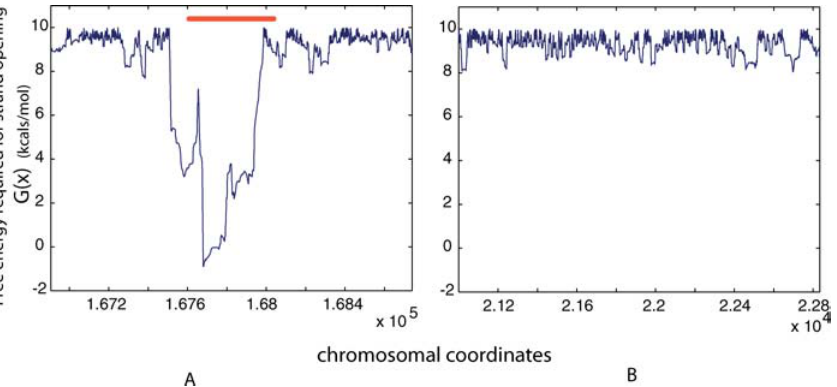
Figure 3. ARS Elements Are More Destabilized Than Other Parts of the Genome (A) The SIDD profile of a region (bp 166936–168740) of Chromosome 6, containing ARS606 (position marked in red). (B) For contrast, the SIDD profile of a randomly chosen but representative genomic location of equal length (Chromosome 6, bp 21000–22834). Graphs of all 39 ARS elements are presented in Protocol S1. DOI: